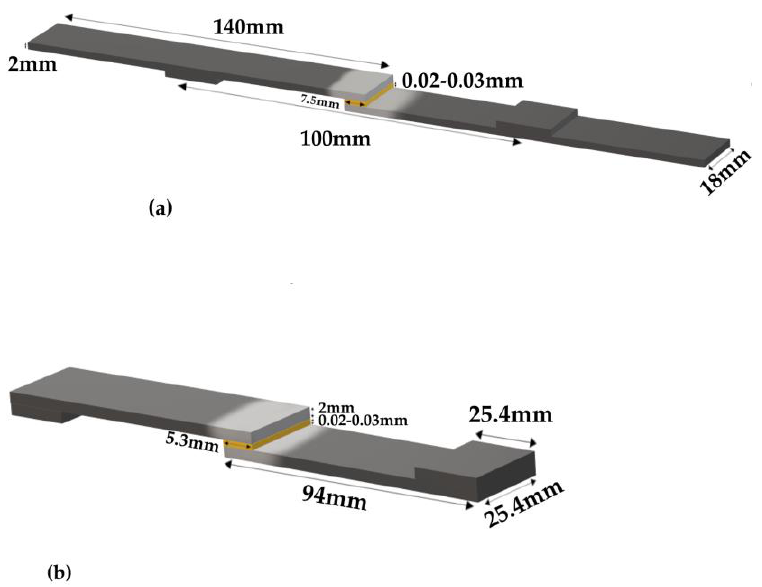
Figure 2. Adhesive single-lap joint specimens ( a ) for three-point bending test ( b ) for tensile test.